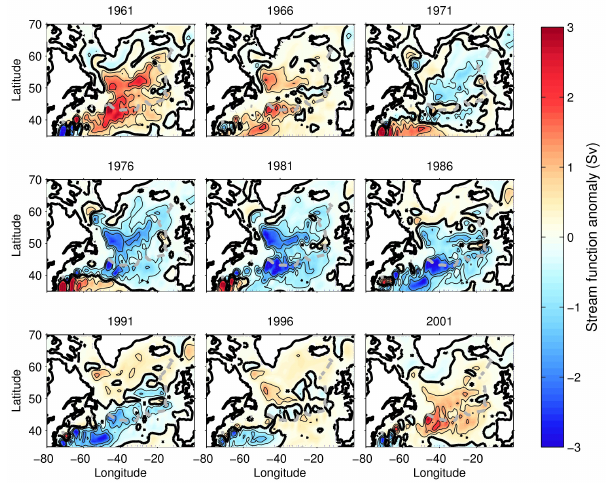
Figure 7. As Fig. 6, but for barotropic stream function anomalies (Sv) of a sensitivity experiment with variable wind and climatological heat fluxes (WSC circulation component).